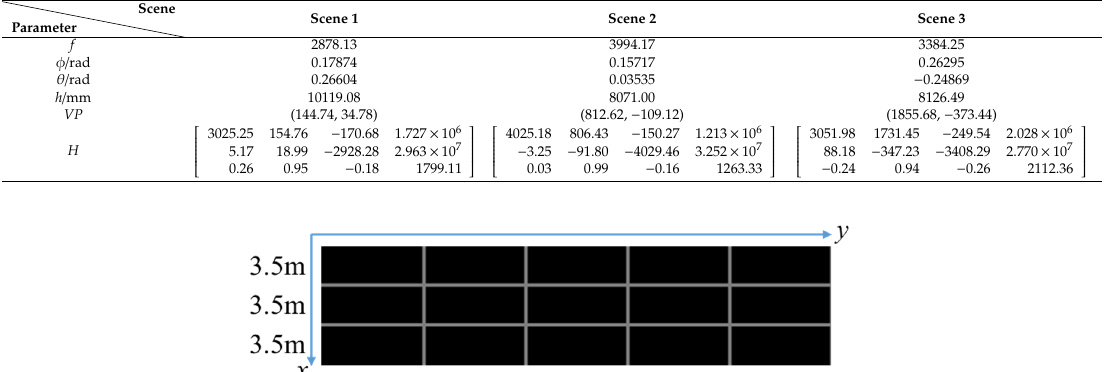
Table 2. Camera calibration results of dataset road scene.